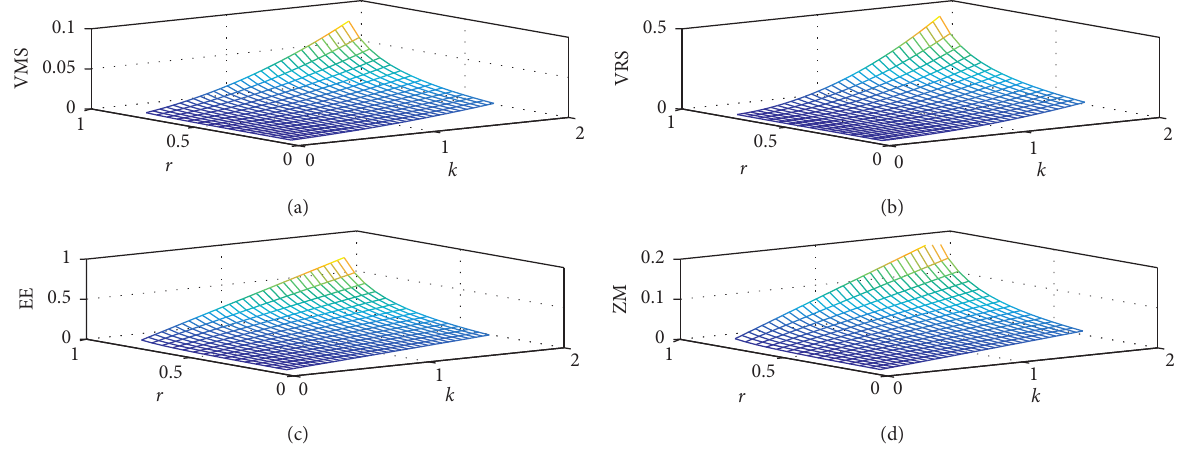
Figure 3: Sensitivity analysis of consumers’ carbon sensitivity coefficient and cost subsidy